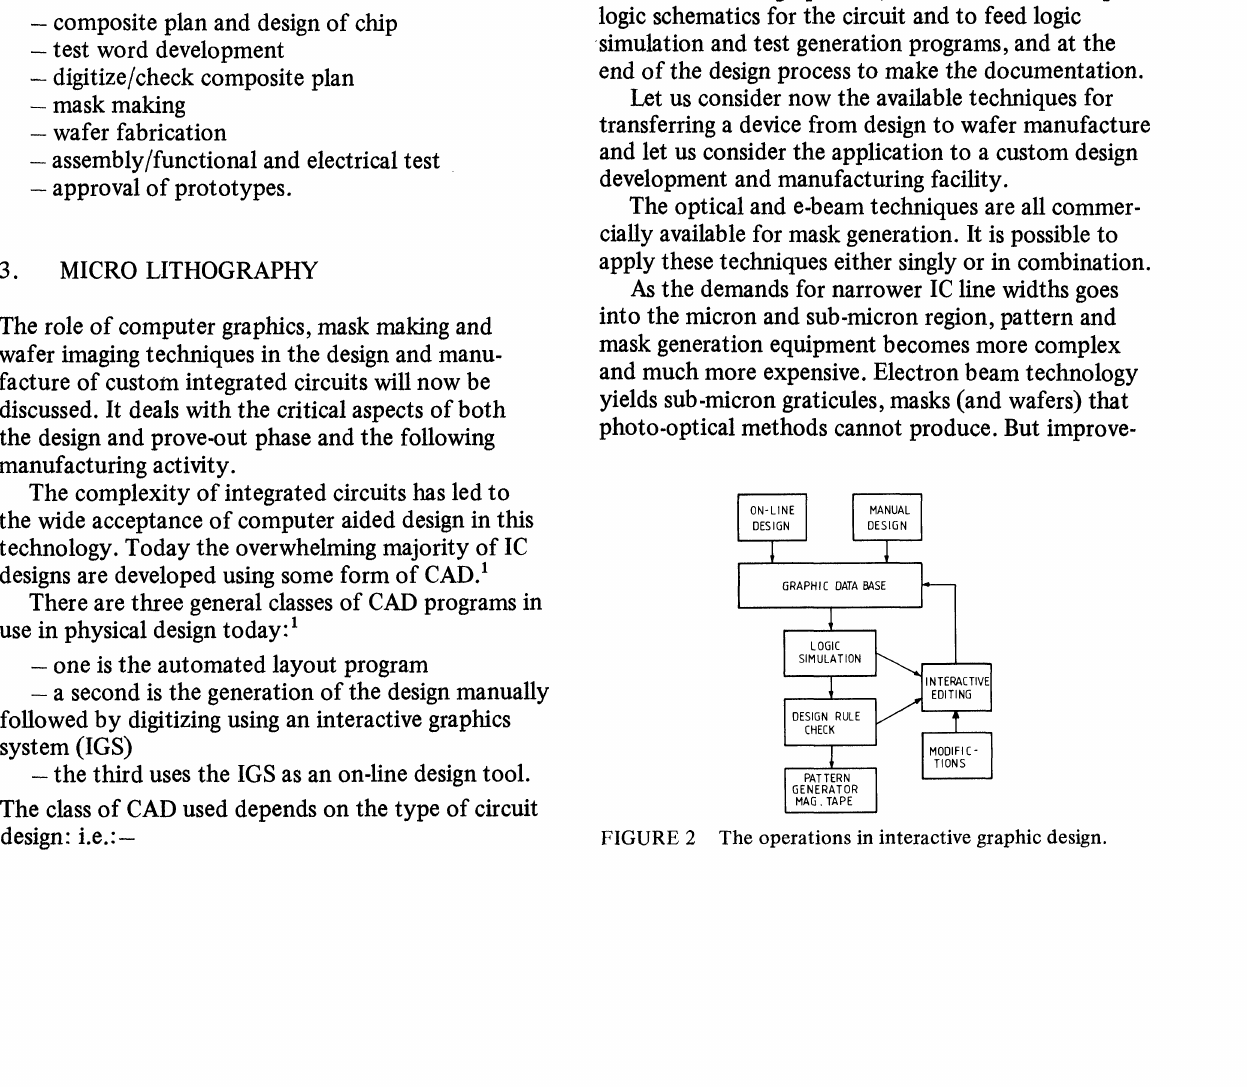
FIGURE The significant parts of the semiconductor development laboratory.